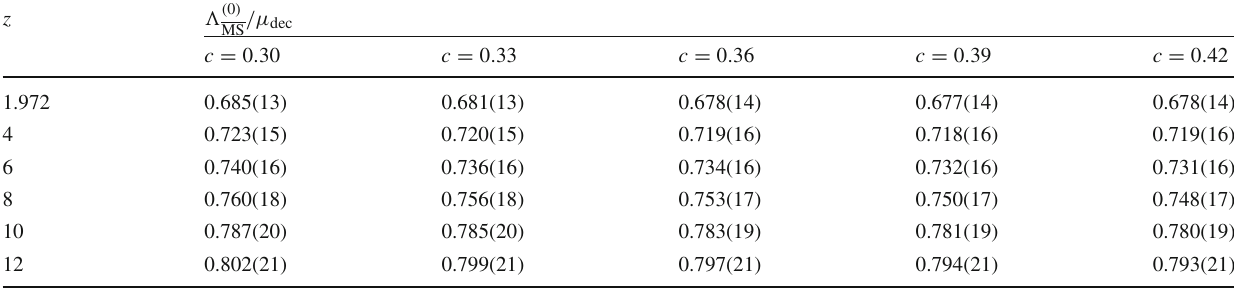
/μ dec corresponding to different values of MS